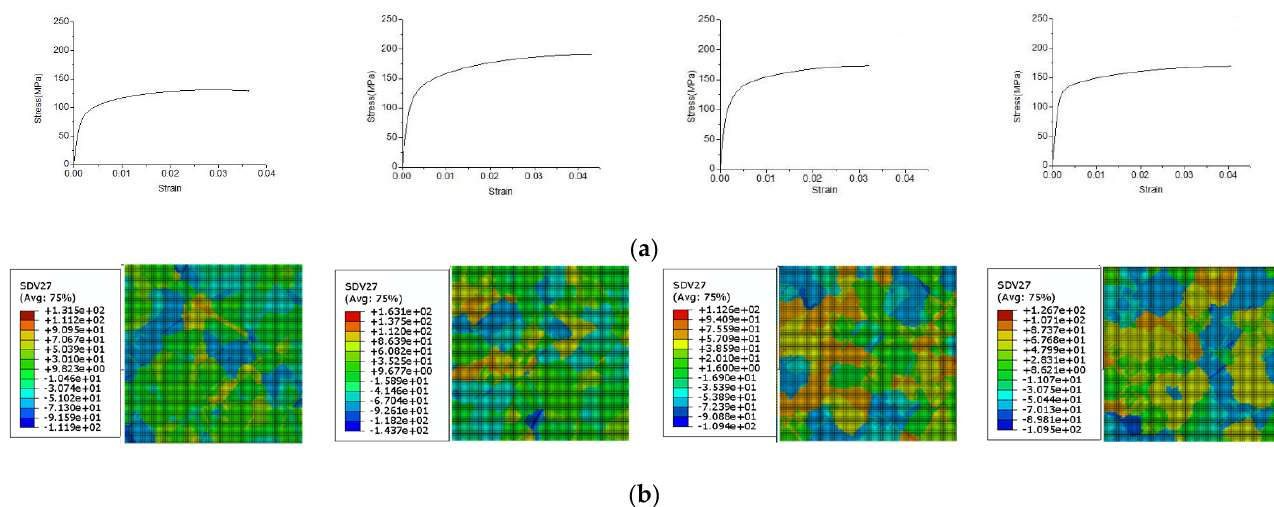
Figure 8. Mechanical responses in crystal plasticity model [138]: ( a ) stress-strain curve; and ( b ) shear stress. (Reprinted/adapted with permission from Ref. [138], 2020, Zhao Zhang).